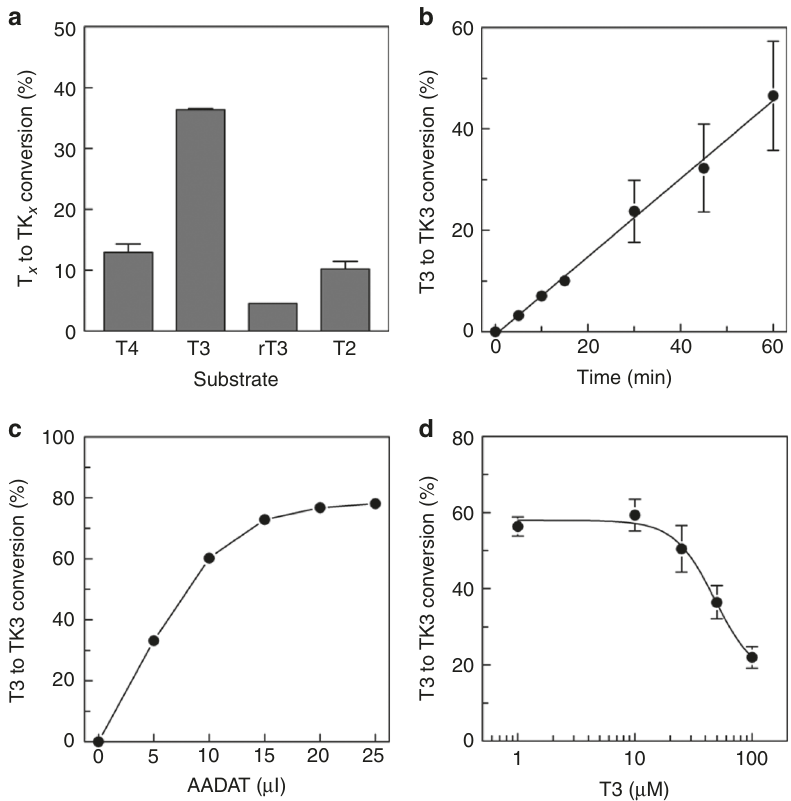
Fig. 4 AADAT converts T3 and T4 to their respective pyruvic acid metabolites. a shows the conversion of T3 and T4 to their pyruvic acid metabolites TK3 and TK4 in cell lysates of hAADAT over-expressing COS-1 cells. Cell lysates were incubated with [I 125 ]-T3 or [I 125 ]-T4 (2 × 10 5 c.p.m.) in the presence of 0.1 mM pyridoxal 5 ′ -phosphate and 1 mM α -ketoglutaric acid for 30 min and the resulting radio-labeled metabolites were separated by UPLC. The conversion of T3 to TK3 depends on the incubation time ( b ) and amount of cell lysate added to the incubation reaction ( c ) and is saturated at substrate concentrations between 10 and 100 µ M ( d ). The percentage conversion re fl ects the amount of TK3 as a percentage of the total radioactivity eluted from the UPLC column and is corrected for the TK3 production in lysates derived from empty-vector-transfected control cells (which was nearly absent). All data are presented as means ± SEM ( n =